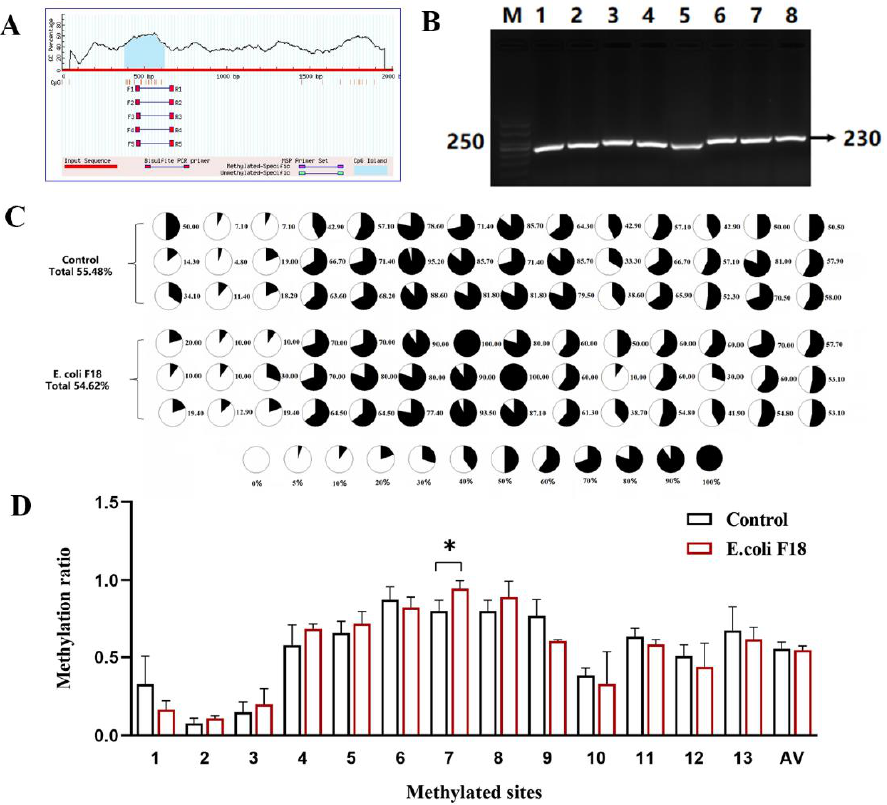
Figure 3. ( A ) CpG island in the CXCL11 gene promoter region. ( B ) PCR-amplified fragment of the CpG island in the CXCL11 gene promoter region. ( C ) The degree of methylation at the discovered CpG sites. On the x axis, 1~13 mean the different CpG sites. Pie charts are used to observe CpG sites, and the black area represents the degree of methylation. AV: the average degree of methylation. ( D ) Differential methylation analysis from E. coli F18-infected and -uninfected IPEC-J2, * p < 0.05.